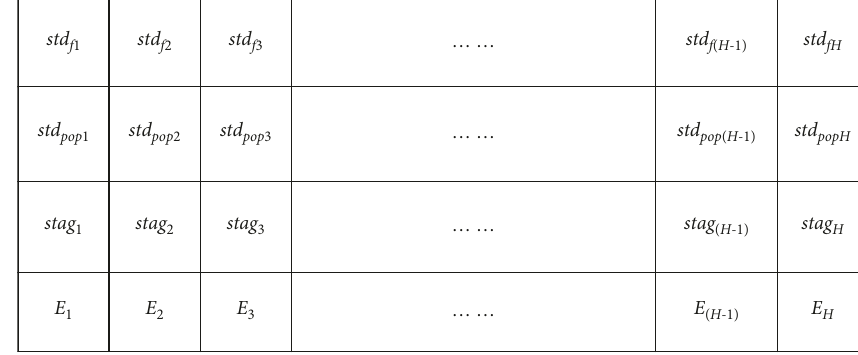
Figure 1: The historical experience